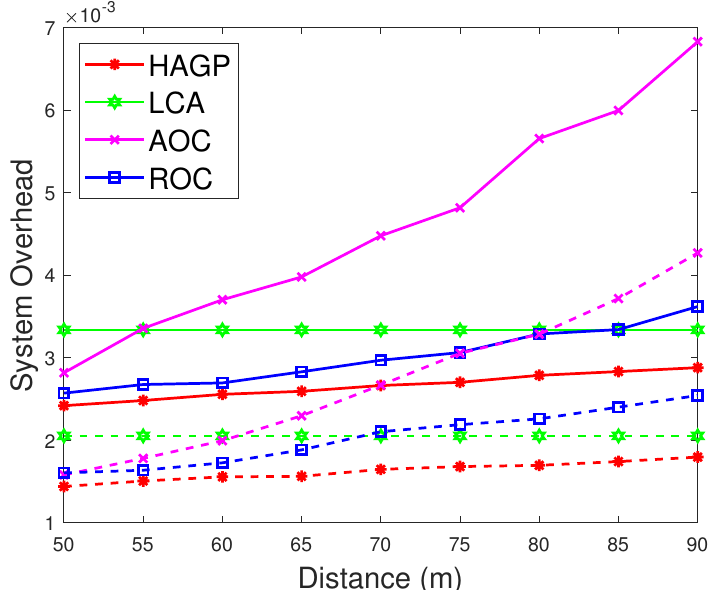
Figure 5. Overall system overhead vs. distance and λ t . The solid curves represent λ t = 0.8, while the dash curves represent λ t =